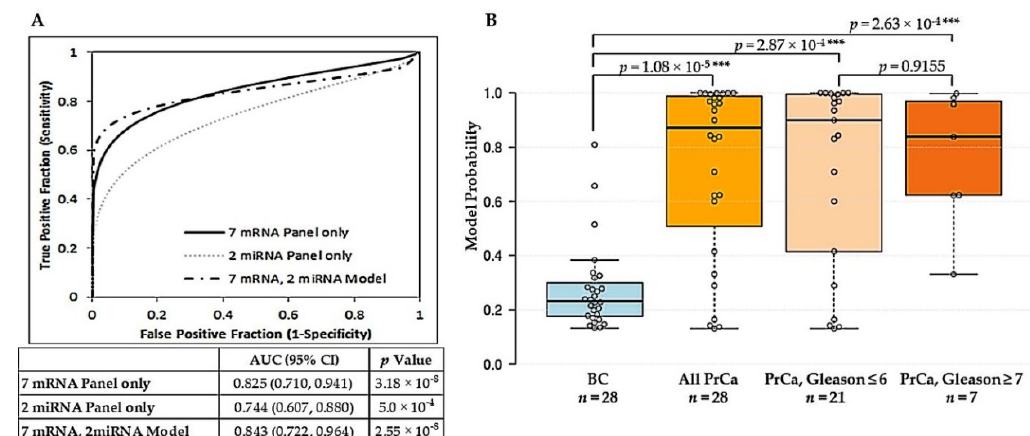
Figure 3. Combined urinary Vn96-isolated EV seven mRNA and two miRNA model for prostate cancer discrimination. ( A ) ROC curve analysis showing discrimination of Prostate Cancer (PrCa; n = 28) from Benign Control (BC; n = 28) using the optimized seven mRNA reference-free panel, the two miRNA panel result (geometric mean of miR-375-3p and miR-574-3p), and the model combining the panels. AUC, 95% CI and p value for each panel and the model are provided below the plot. ( B ) Box plot graphically depicting prostate cancer classification probabilities calculated using the seven mRNA/2 miRNA model for Benign Controls (BC; n = 28), all Prostate Pancer (PrCa; n = 28), PrCa Gleason 6 or below ( n = 21), and PrCa Gleason 7 or above ( n = 7). Plot details are as for Figure 1. Differences denoted by asterisks are statistically significant (* p < 0.05, ** p < 0.01, and *** p < 0.001). p values were obtained using the Mann-Whitney U test to compare differences.